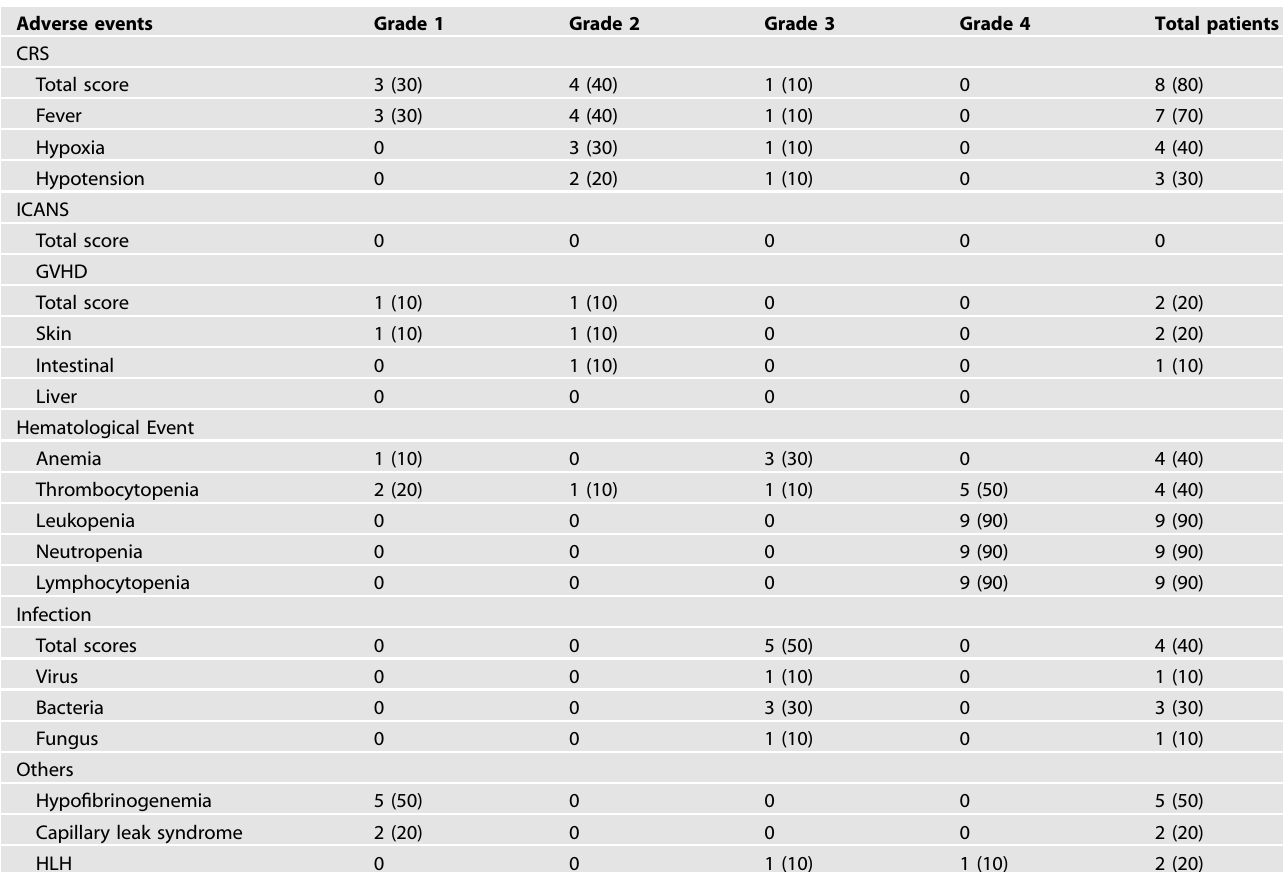
Table 2. Adverse events within a month post